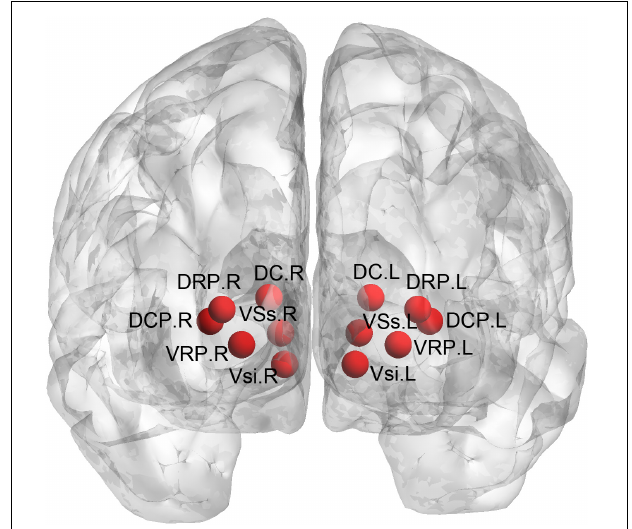
FIGURE 1 | Definition of the striatal subregions. DC, dorsal caudate; VSs, superior ventral striatum; VSi, inferior ventral striatum; DRP, dorsal rostral putamen; DCP, dorsal caudal putamen; VRP, ventral rostral